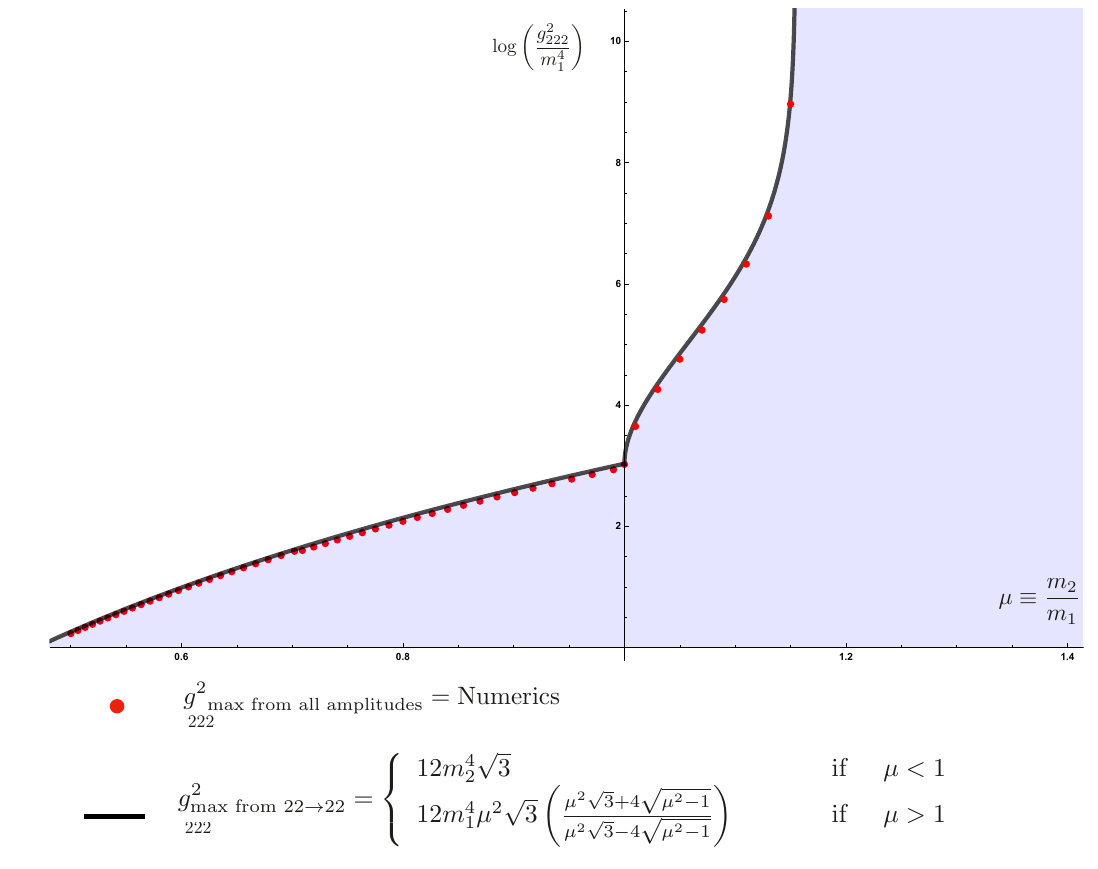
Figure 3. Upper bounds on the cubic coupling g Solid line: 222 as a function of (cid:22) (cid:17) m 2 =m 1 . analytic bound based on the scattering of the lightest even particle, from [2]. Red dots: the numeric bound obtained from all two-to-two processes as discussed in the main text. The shaded region represent the allowed region. When the even particle is the lightest, we can solve analytically